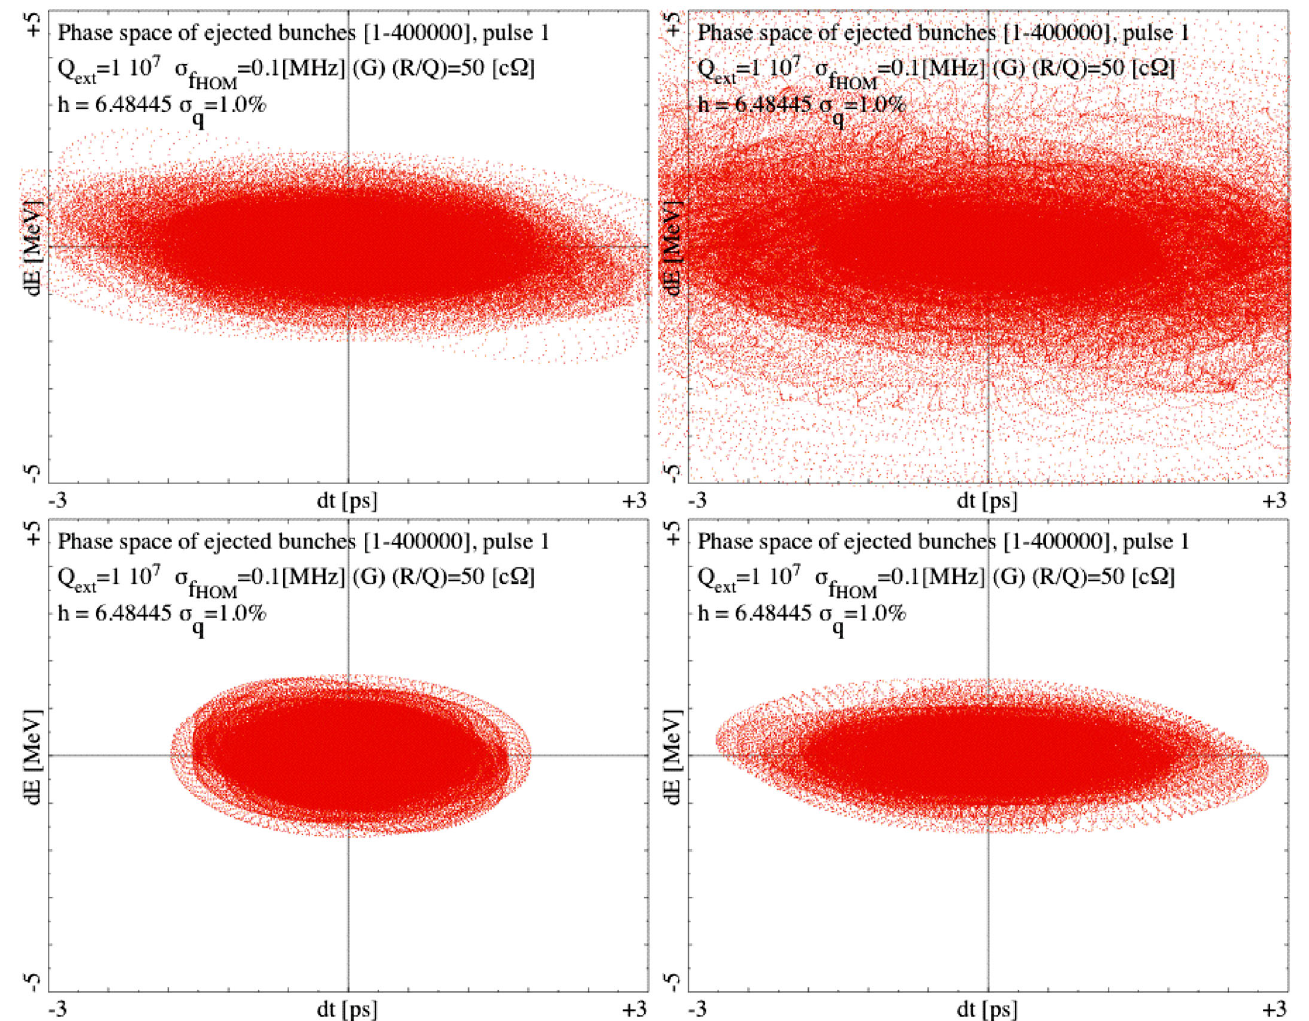
FIG. 16. (Color) Phase-space plots for four different choices of random f H scatter with the same (cid:1) (cid:3) f , identical HOM center frequency i ( h ¼ 6 : 484 45 ), and the same bunch-charge sequence each. Scaling ½(cid:3) 3 ps (cid:4) (cid:8) ½(cid:3) 5 MeV (cid:4) h f H